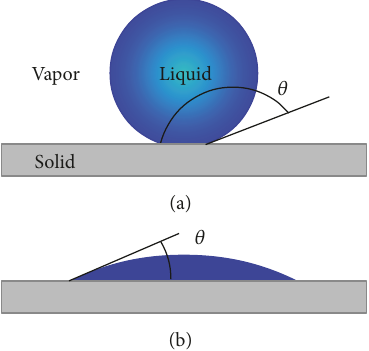
Figure 2: Contact angle between a drop and a substrate: (a) nonwettable substrate and (b) a partially wetted